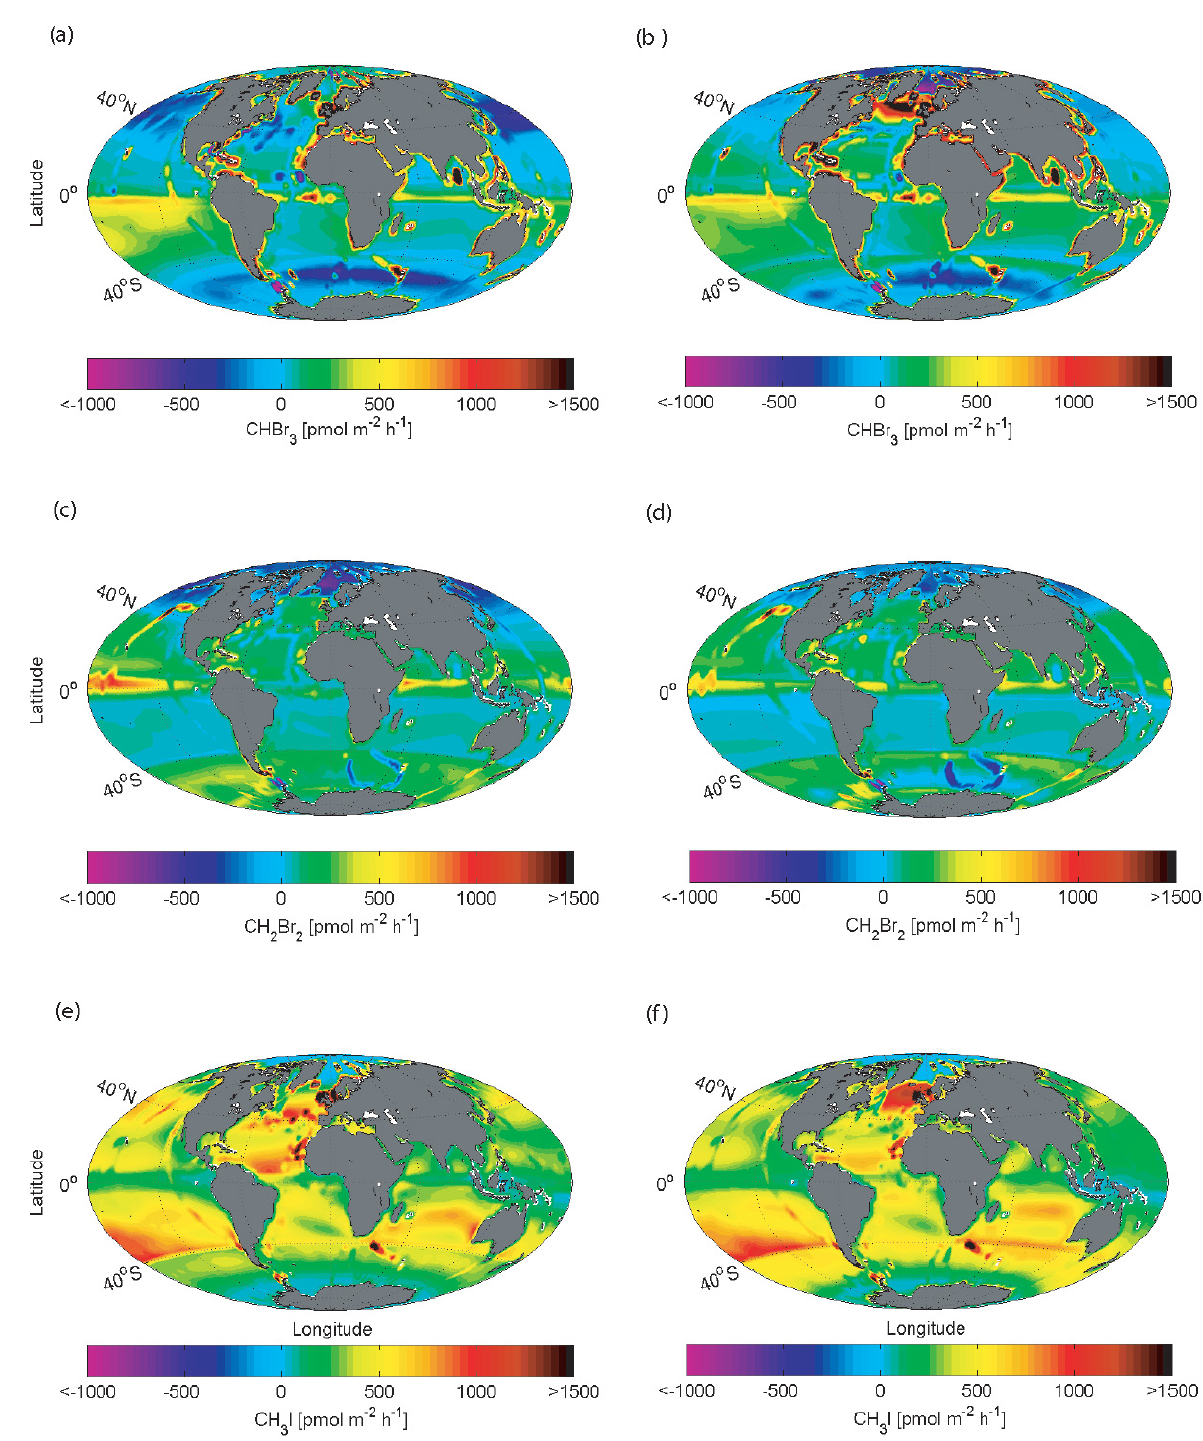
Fig. 5. Global sea-to-air flux climatology of bromoform (a, b) , dibromomethane (c, d) and methyl iodide (e, f) in pmolm − 2 h − 1 based on the RF ( a, c, e , left column) and OLS ( b, d, f , right column)